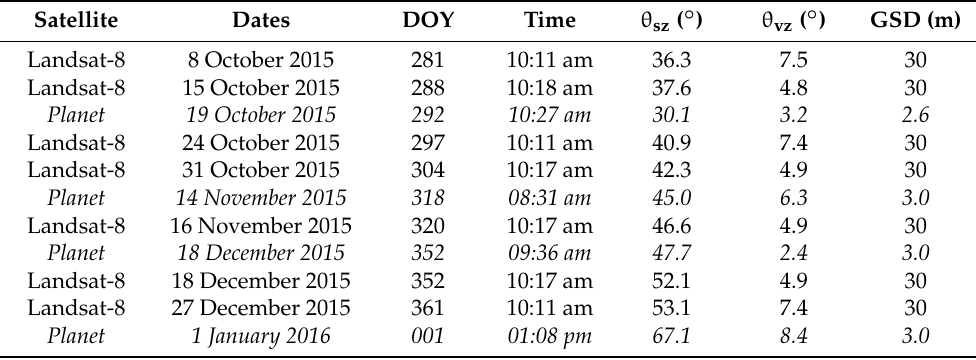
Table 1. Acquisition details for the Planet (in italics) and Landsat-8 satellite images. DOY is the day of year, θ sz is the sun zenith angle, θ vz is the view zenith angle, and GSD is the ground sampling distance. Satellite